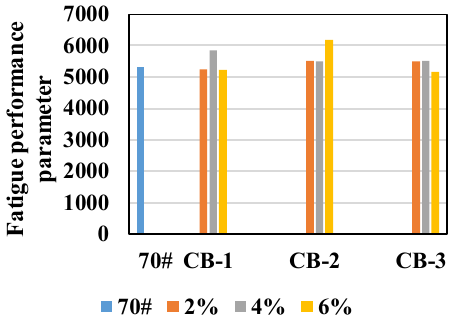
Figure 7. Fatigue performance parameters of unaged asphalt specimens.